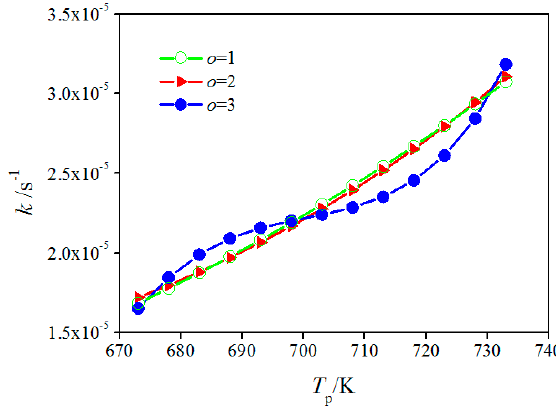
Figure 9. Comparisons of initial and modified Arrhenius equations. Table 3. Relative errors of NAMW of PEW at four measure points (N4, N5, N7, and N11) for initial and modified Arrhenius equations.